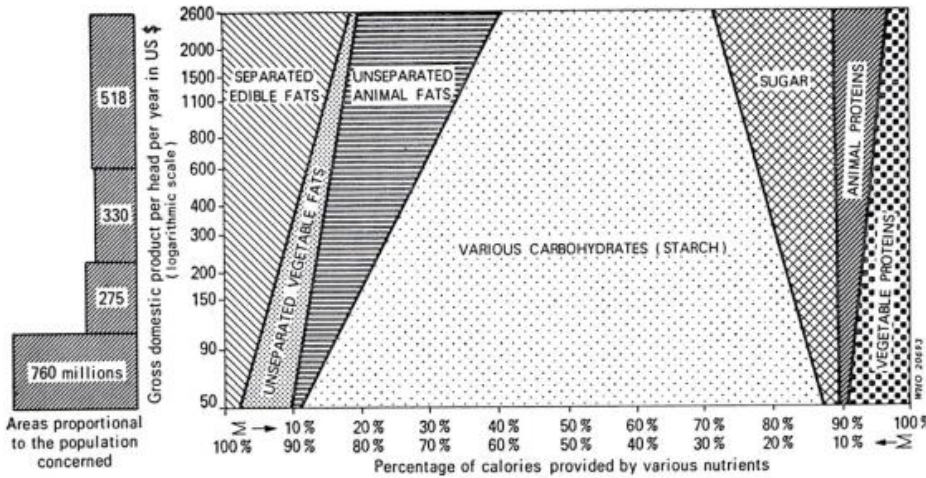
Figure 6. Calories derived from fats, carbohydrates, and proteins as a percent of total calories according to the income of the countries, data from [25].